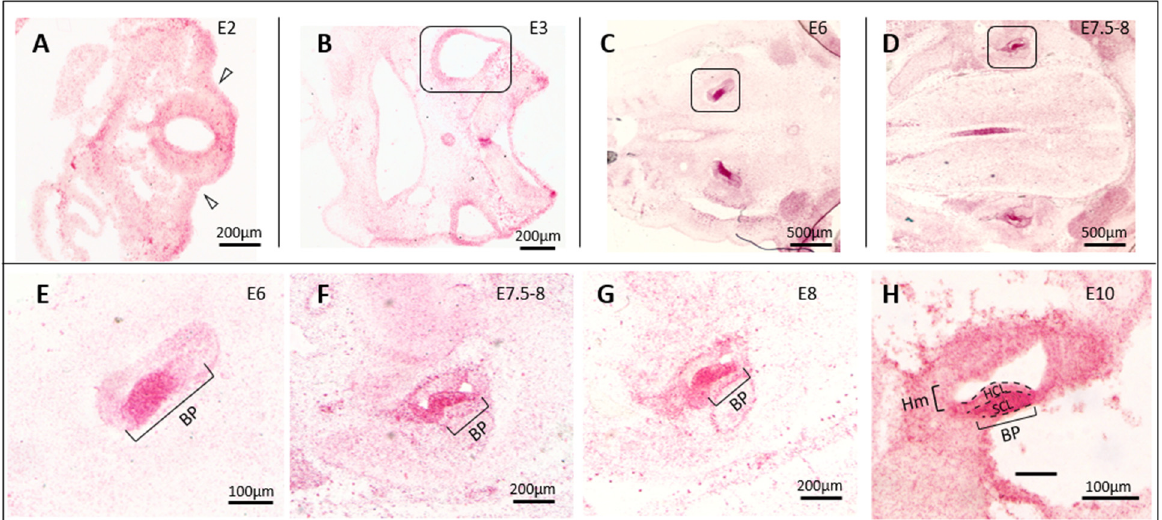
Figure 2. Endogenous cTyro3 mRNA expression levels in the embryonic chick inner ear. ( A – H ) cTyro3 mRNA expression in the inner ear was visualized at E2-E6, E7.5, E8 and E10-11 (n = 1 to 6 per specified day). Expression level is low at ( A ) E2 when the otic cup invaginates (open arrowheads) but increases with age ( B – D ) as the inner ear sensory organs begin to form. Positive staining is particularly robust in the anlage of the basilar papilla, the auditory sensory organ in birds (boxed regions at E6 and E7.5–8). ( E – H ) The sensory region of the basilar papilla (BP) has exceptionally high cTyro3 mRNA expression from E6-E10. ( H ) The supporting cell layer of the BP has somewhat higher cTyro3 mRNA expression than the hair cell layer at E10. Abbreviations: BP, basilar papilla; E, embryonic day; Hm, non-sensory homogene cells; HCL, hair cell layer; SCL, supporting cell layer.